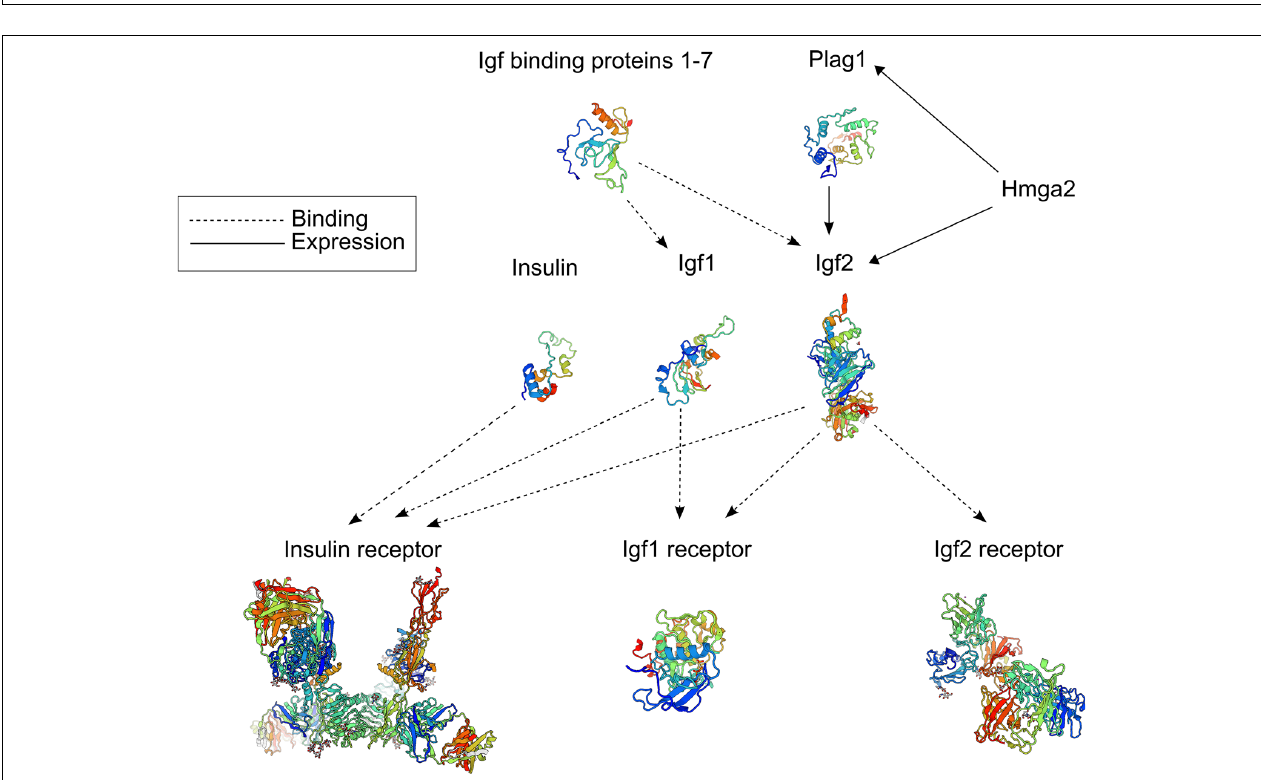
micro RNAs (miRNA) binding to its 3 (cid:48) -UTR region, has